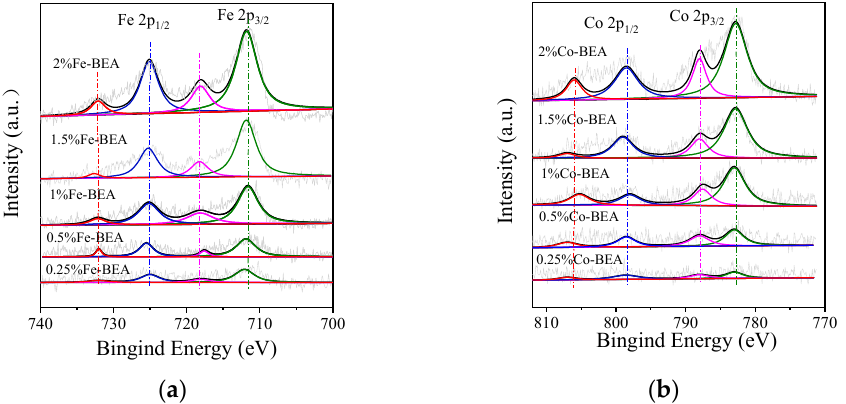
Figure 3. ( a ) XPS spectra of Fe-BEA in Fe 2p orbitals; ( b ) XPS spectra of Co-BEA in Co 2p orbitals.